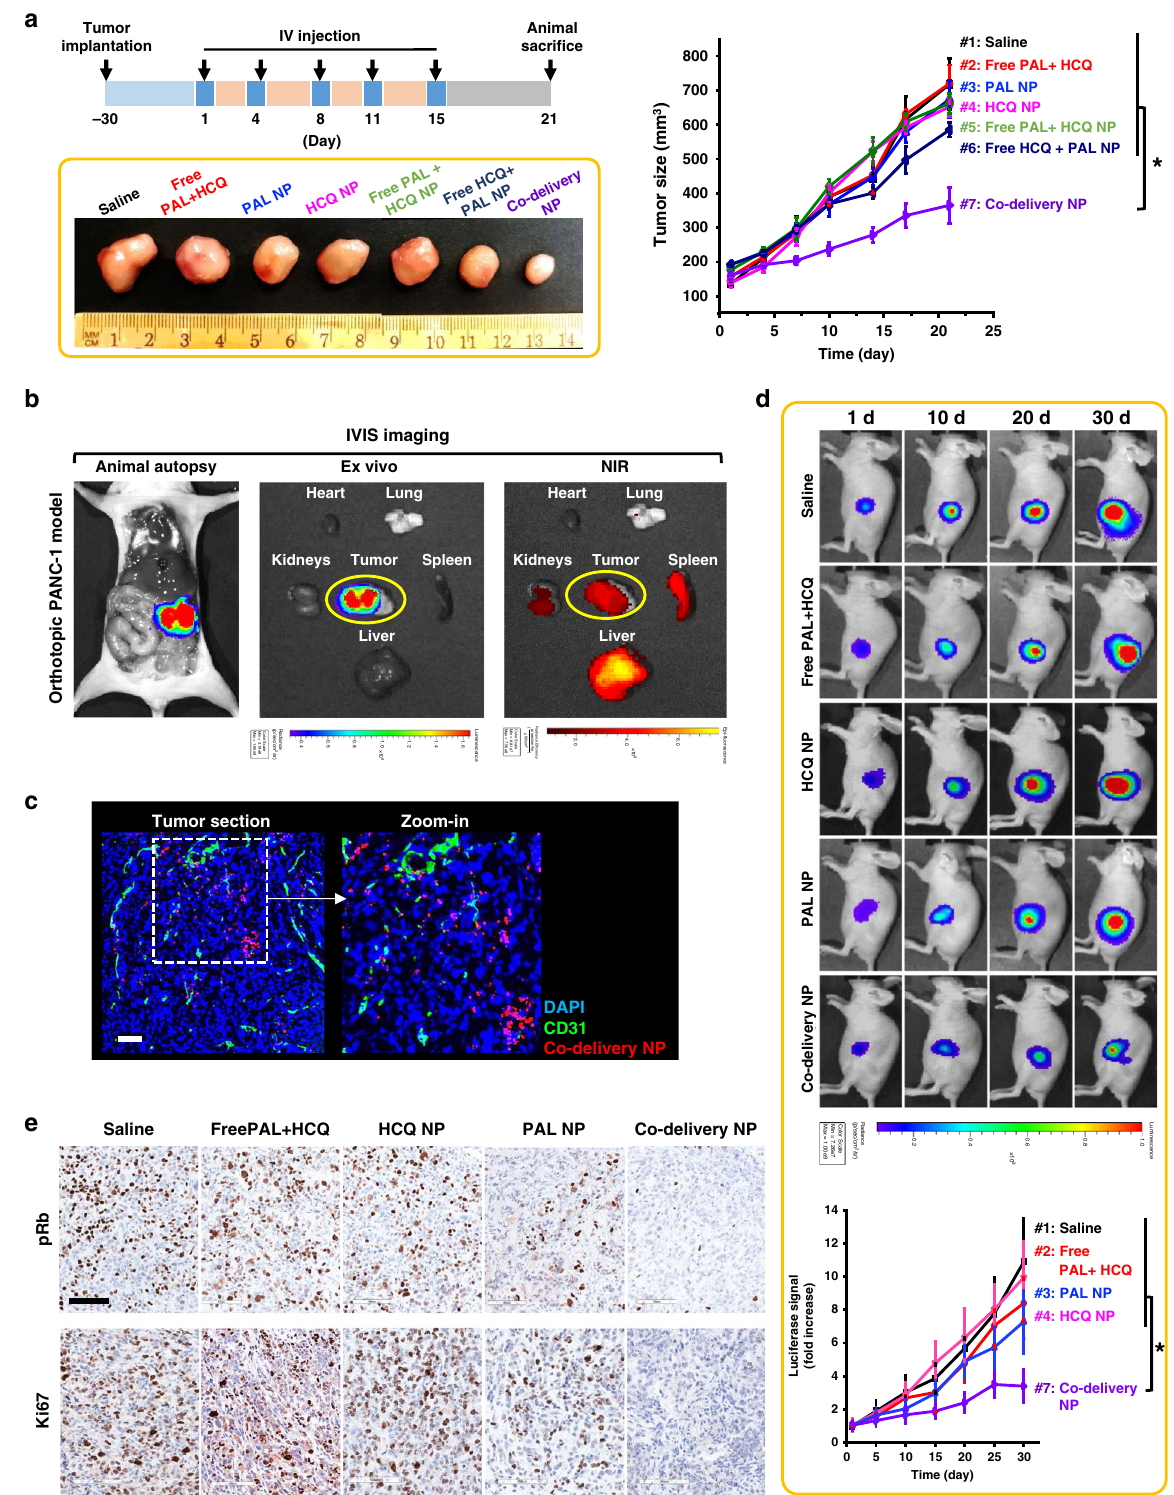
Synergistic antitumor effects by co-delivery NP . For proof of principle, we fi rst performed the ef fi cacy study in a subcutaneous PANC-1 xenograft model. As indicated in the treatment scheme (Fig. 4a), PANC-1 tumor-bearing mice received 5 i.v. injections of co-delivery NP at particle dose of 210 mg/kg/injection (PAL: